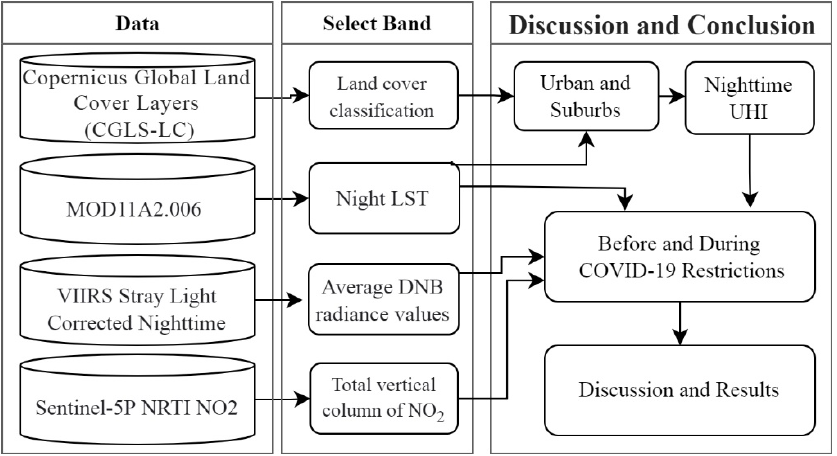
Figure 4. Research process.